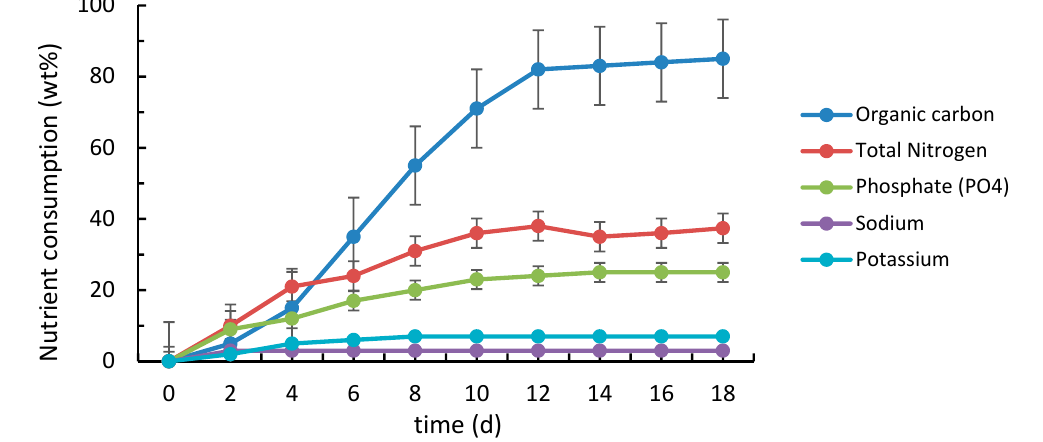
Figure 4. Nutrient consumption by the microalgae in the C2 treatment.